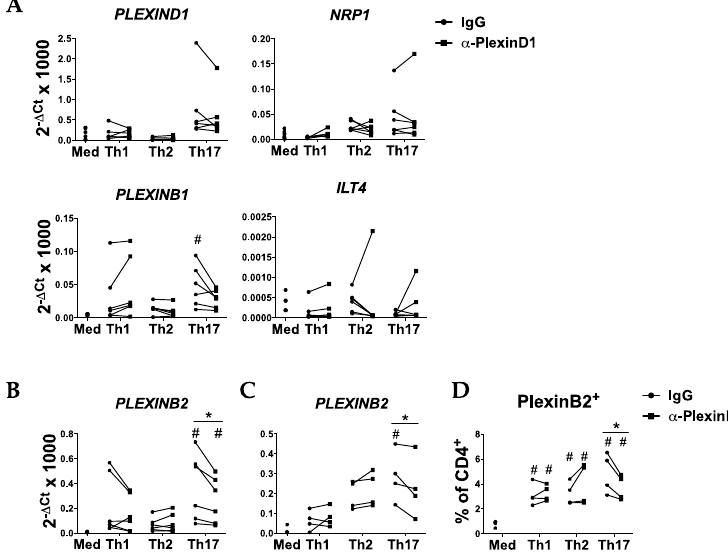
Figure 5. Sema4A-PlexinD1 axis induces the expression of PlexinB2 in Th17 cells. ( A ) mRNA expression of Sema4A receptors in naïve CD4 + T cells di ff erentiated in medium or Th1, Th2 or Th17 di ff erentiation cocktails in the presence of an anti-PlexinD1 antibody or its respective isotype control for 7 days ( n = 6). ( B – D ) PlexinB2 mRNA ( B,C ) and protein ( D ) expression in naive CD4 + T cells di ff erentiated in medium or Th1, Th2 or Th17 di ff erentiation cocktails in the presence of an anti-PlexinD1 antibody or its respective isotype control for 7 days ( B , n = 6) and 3 days ( C,D , n = 4). Data are presented as connected dots. * p < 0.05. # p < 0.05 compared to the